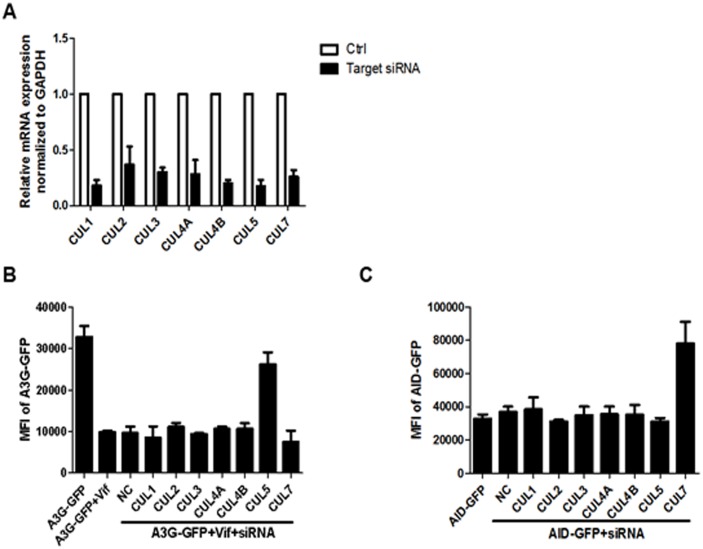
Detection of the knockdown efficiency of various siRNAs.(A) HEK293T cells were transfected with indicated siRNAs. After 48 hr, the total RNA was extracted with TRIZOL and the mRNA expression of each gene was detected by qRT-PCR. Error bars represent the SEM of three independent experiments. (B) HEK293T cells were transfected with pcDNA3.1-A3G-GFP, pcDNA3.1-Vif, and indicated siRNAs. The GFP expression was detected with a PE Envision at 48 hr post-transfection. Error bars represent the SEM of three independent experiments. (C) HEK293T cells were transfected with pcDNA3.1-AID-GFP and the indicated siRNAs. The GFP expression was detected with a PE Envision at 48 hr post-transfection. Error bars represent the SEM of three independent experiments.